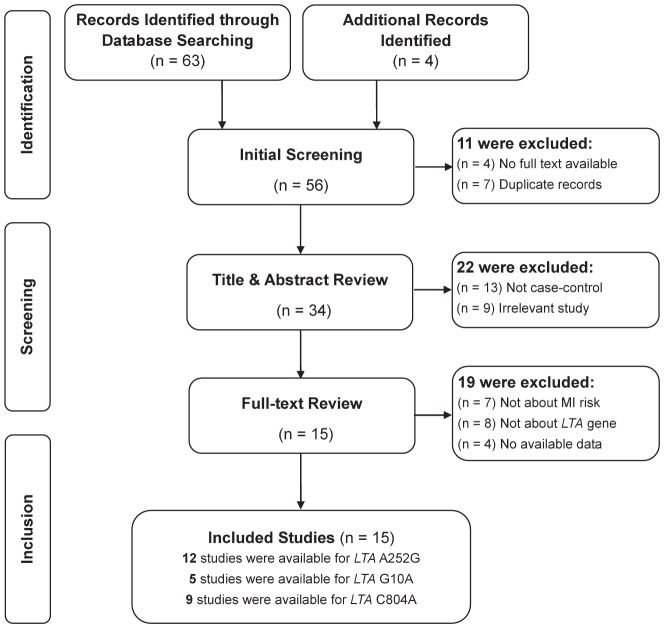
Flow diagram of the selection of studies and specific reasons for exclusion from the present meta-analysis.